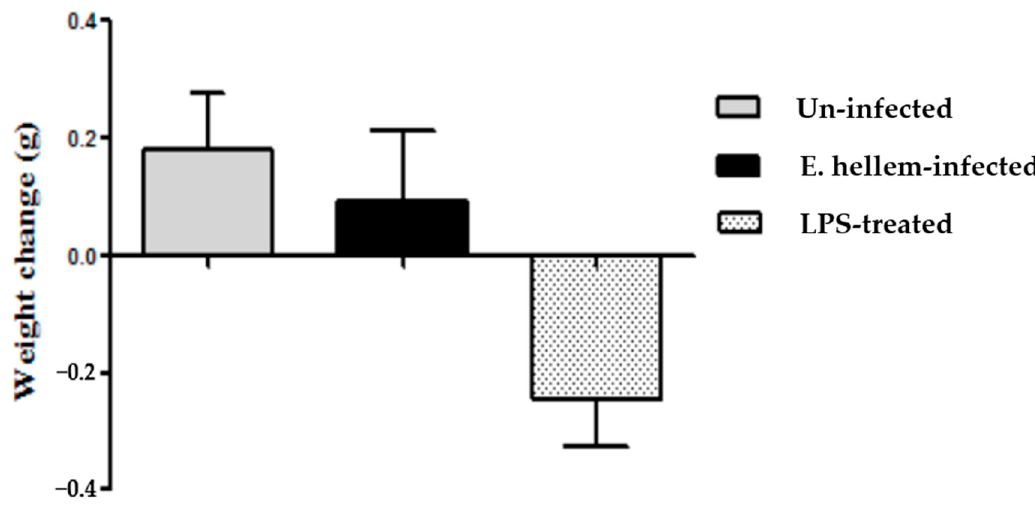
Figure 2. Body weights change. Body weights of all three groups of mice (uninfected, E. hellem -infected, and lipopolysaccharide (LPS)-treated) were measured. The first measurements were done on the last day of dexamethasone-injection and then measured again on the day of mice sacrifice, for a total 18 days period of time. The body weight changes over time were calculate and are represented in the figure. LPS-treated mice lost about 0.2 g of body weight over time, while uninfected mice and E. hellem -infected mice gain about 0.2 g of body weight at the end of the experiment. No significant di ff erences among groups were observed. ( n = 8 for each group in one experiment, and the experiments have been repeated for three